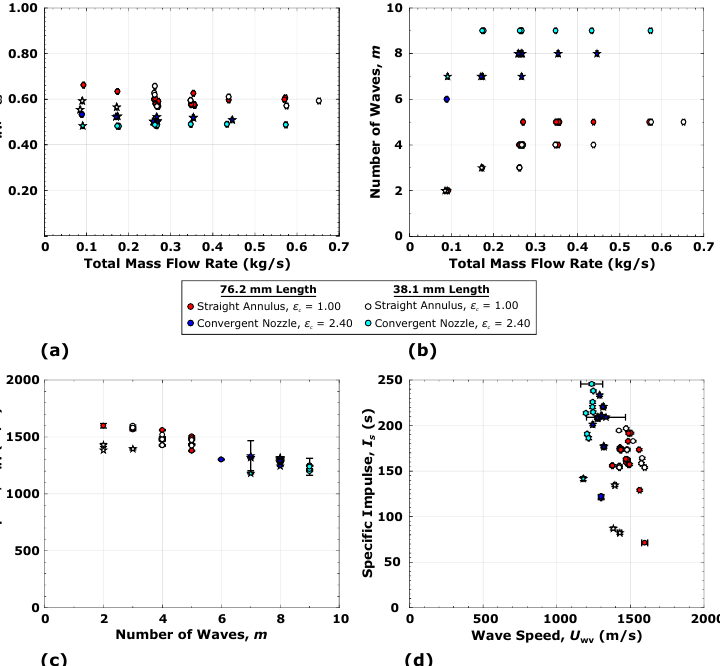
Figure 19. Summary of the detonation mode characteristics for the total mass flow conditions at φ = 1.15, depicting the ( a ) wave speed percentage of ideal and ( b ) number of waves m , as well as the wave speed sensitivity to the ( c ) number of waves and ( d ) specific impulse I s . Depending on the flow condition and convergent nozzle geometry, the engine operates in either a corotating ( • ) or counter-propagating mode ( (cid:63)